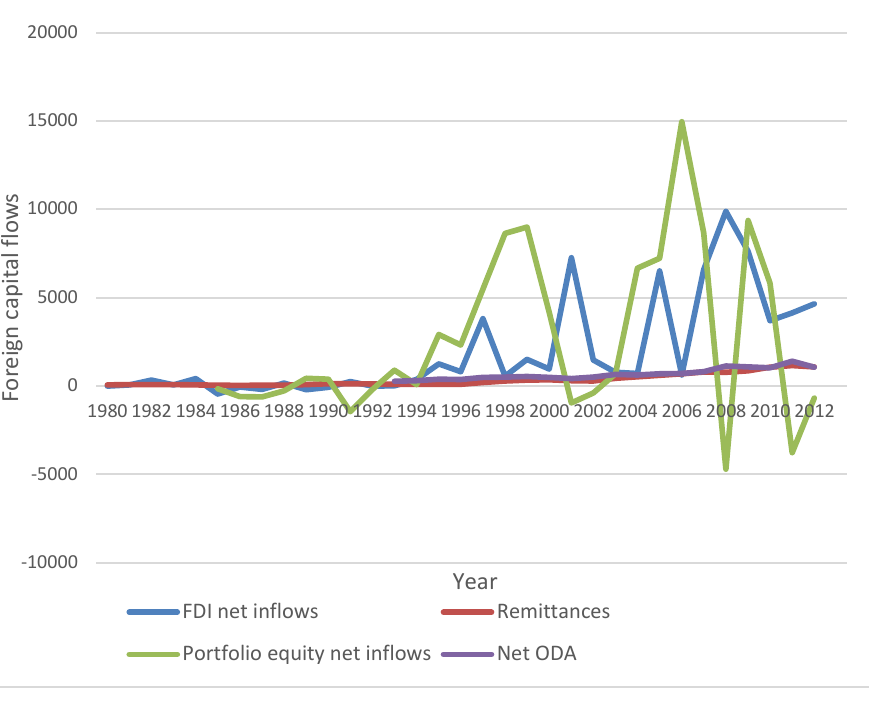
FIGURE 1: Selected Foreign capital flows to South Africa in current US$ million Source: Authors’ calculations based on World Bank WDI database